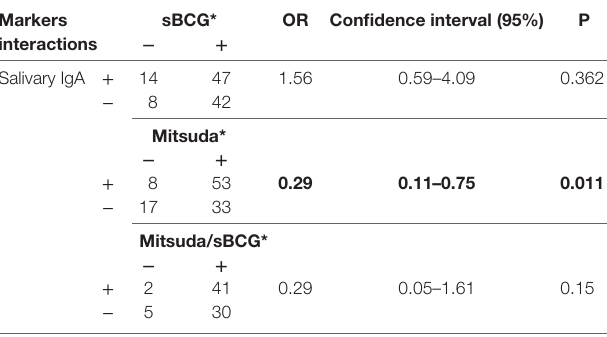
Bold fonts were used to emphasize the significant values. sBCG ( − ) = worse prognosis (0 cBCG) and ( + ) = better prognosis (1 and 2 sBCG). Mitsuda ( − ) = worse prognosis (0–3 mm) and ( + ) = better prognosis ( ≥ 4 mm). Mitsuda/sBCG (–) = worse prognosis (Mit < 4/sBCG-ID = 0) and ( + ) = better prognosis (Mitsuda ≥ 4/sBCG ≥